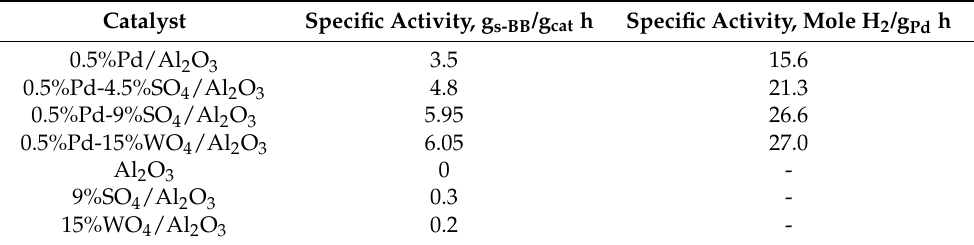
Table 1. Results of s-BB hydrogenation in an autoclave at 90 ◦ C and 20 atm. Catalyst